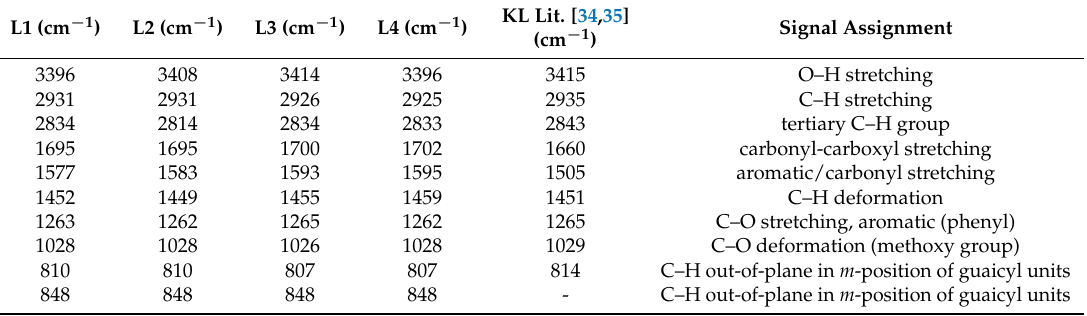
Figure 3. Fourier transform infrared (FTIR) spectra of lignin purification fractions: L1 (blue), L2 (red), L3 (green), and L4 (purple). Table 2. Fourier transform infrared (FTIR) functional group assignment of lignin fractions. The most important signals are listed with wavenumbers and signal assignment for all four fractions, L1 to L4 and compared with literature data of kraft lignin